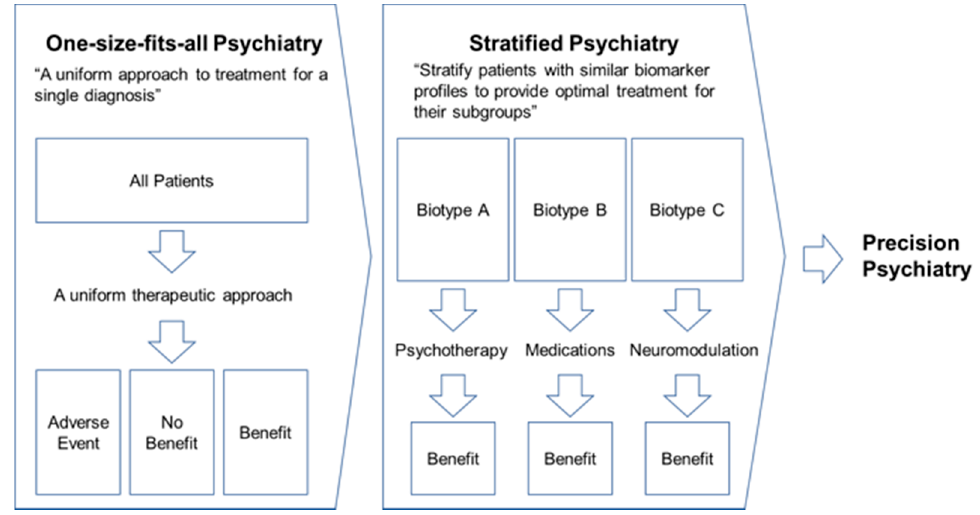
Figure 6. A paradigm shift from “One-size-fits-all Psychiatry” to “Stratified Psychiatry”. The approach required for the future of psychiatry is not “a uniform treatment for a specific diagnosis” but “redefinition of diseases based on biotypes related to each diagnosis and development of effective treatments for each biotype”. To realize this goal, it is essential to establish the TMS registry as proposed in this protocol and commission paper.